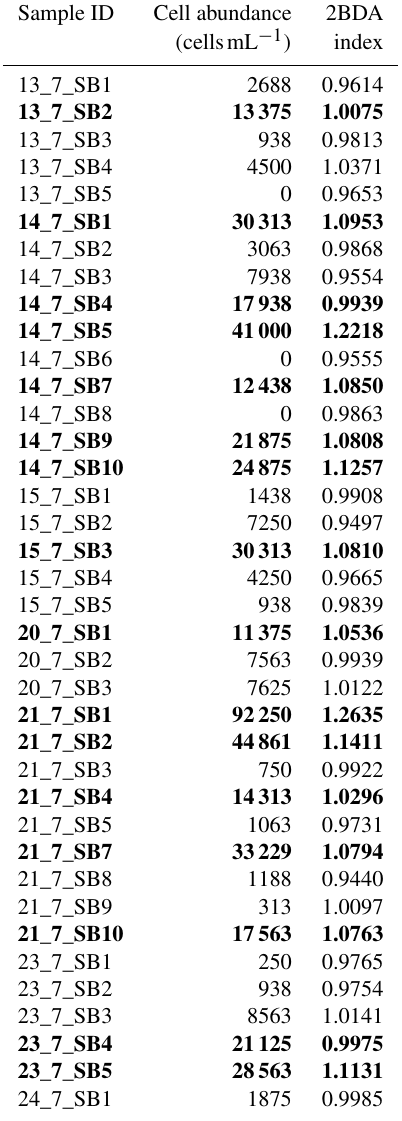
Table B1. Measured algal cell abundance from the field dataset of Cook et al. (2020) with the 2BDA index calculated from coinci- dent hyperspectral measurements. The highlighted rows in bold are samples with cell abundance of greater than 10000cellsmL − 1